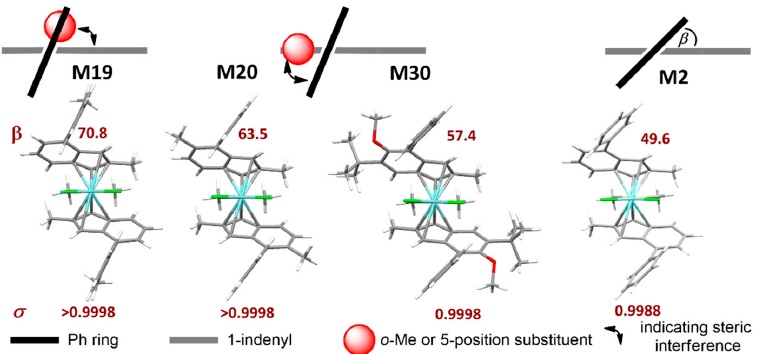
Figure 3. Effect of ortho -substituents of 4-Ph (4- o -Tolyl, M19 ), or substituents in the 5-position of the indenyl ( M20 and M30 ) on the dihedral angle ( β ) between the 4-Ph and the Indenyl plane, and consequent stereoselectivity σ . With increasing β the value of σ also increases, as separation of steric bulk between ‘open’ and ‘closed’ quadrants (see text) is perfected. M2 data provided for comparison. Pictures generated with Mercury 4.2. Stylized sketches show upper indenyl ring (grey), phenyl substituent (black), and methyl or OMe substituent (red). Both can lead to catalysts with near-to-perfect stereoselectivity ( ≤ 0.02 mol% stereoirregular insertions), e.g., M19 (soft lock) and M20 (hard lock); preliminary evidence suggests that the